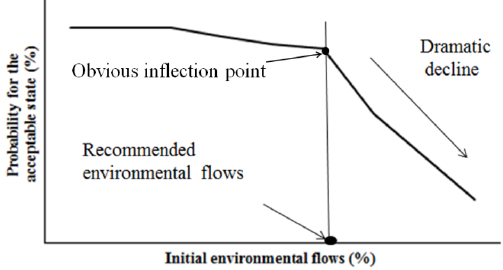
Fig. 3. Illustration of the determination of recommended environ- mental